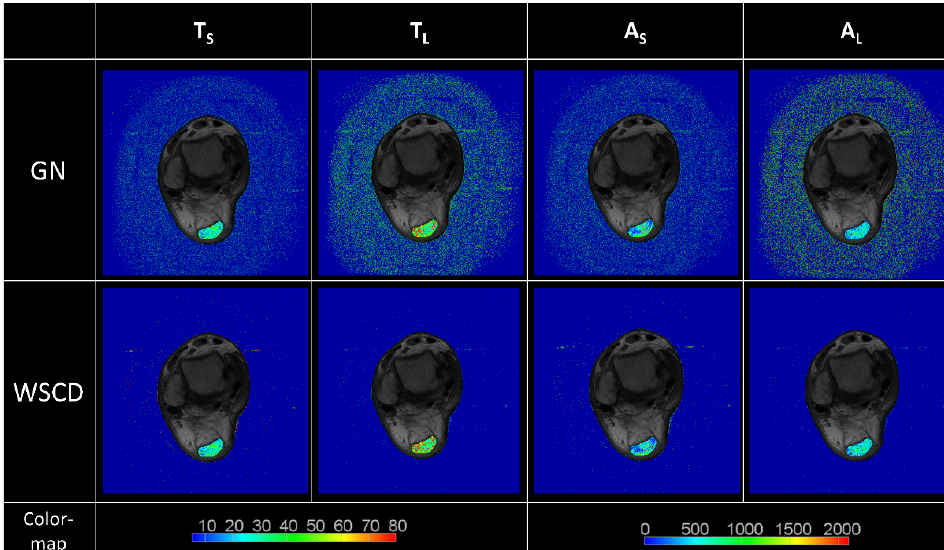
Figure 8. Signal-to-noise comparison between the WSCD and GN methods based on reconstructed T2 maps. The signal reference value was the average of the T2 time in the segmented AT region. The noise reference value was the mean of the T2 time in the air background. The noise level in the T2 maps reconstructed with the GN method was higher than that in the maps reconstructed with the WSCD method.